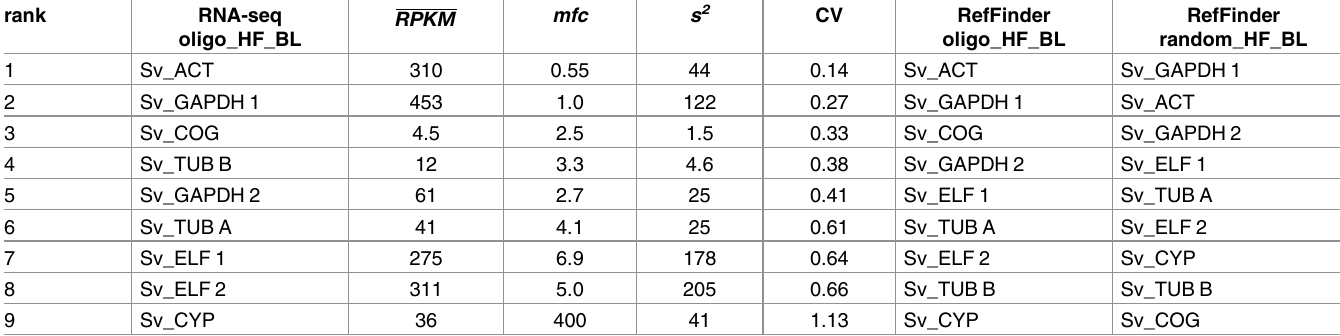
Table 4. Supporting RNA-seqanalysis. Rank of analysedgenes(primer pairs) accordingto their coefficients of variation (CV) for RPKM normalizedtran- script coverage.Maximum fold change( mfc ) and sample standard deviation( s 2 ) are also presented. Oligo(dT)-cDNA librarieswere obtained from buds and leaves from H and F plants. RefFinderoutput for HF_BL is shown for the comparison. rank RNA-seq